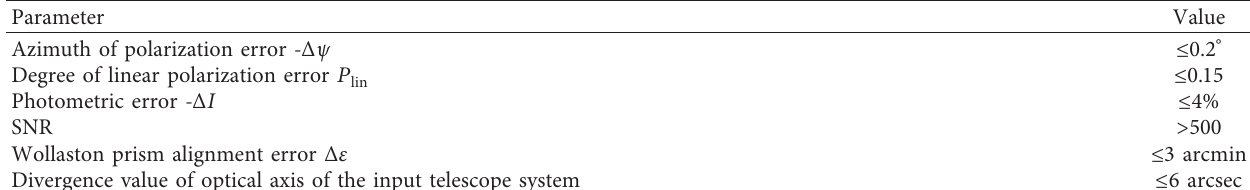
Table 3: Main requirements to ScanPol’s PSA.